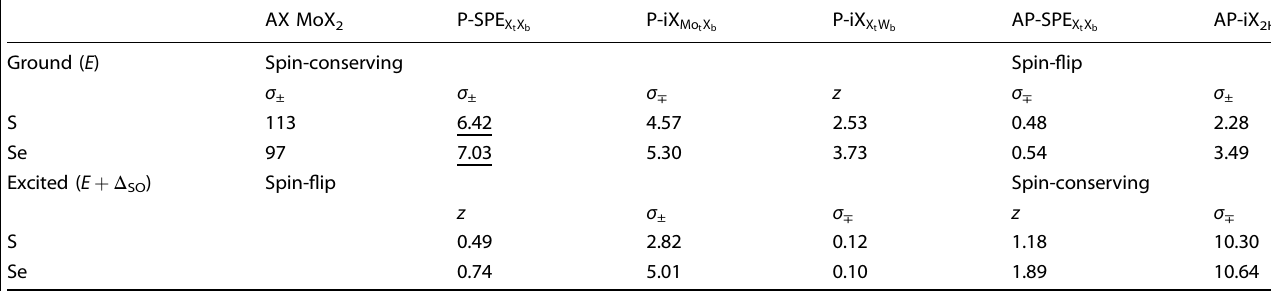
σ + ( σ − ) designates photons with clockwise (counter clockwise) polarization outgoing in positive direction of spin quantization axis. z stands for linear out-of- plane polarization. Here, upper (lower) index corresponds to emission from + K ( − K) valley. For this analysis we employed angular momentum conservation for K-point Bloch states (we used center of coordinate set at a chalcogen atom).